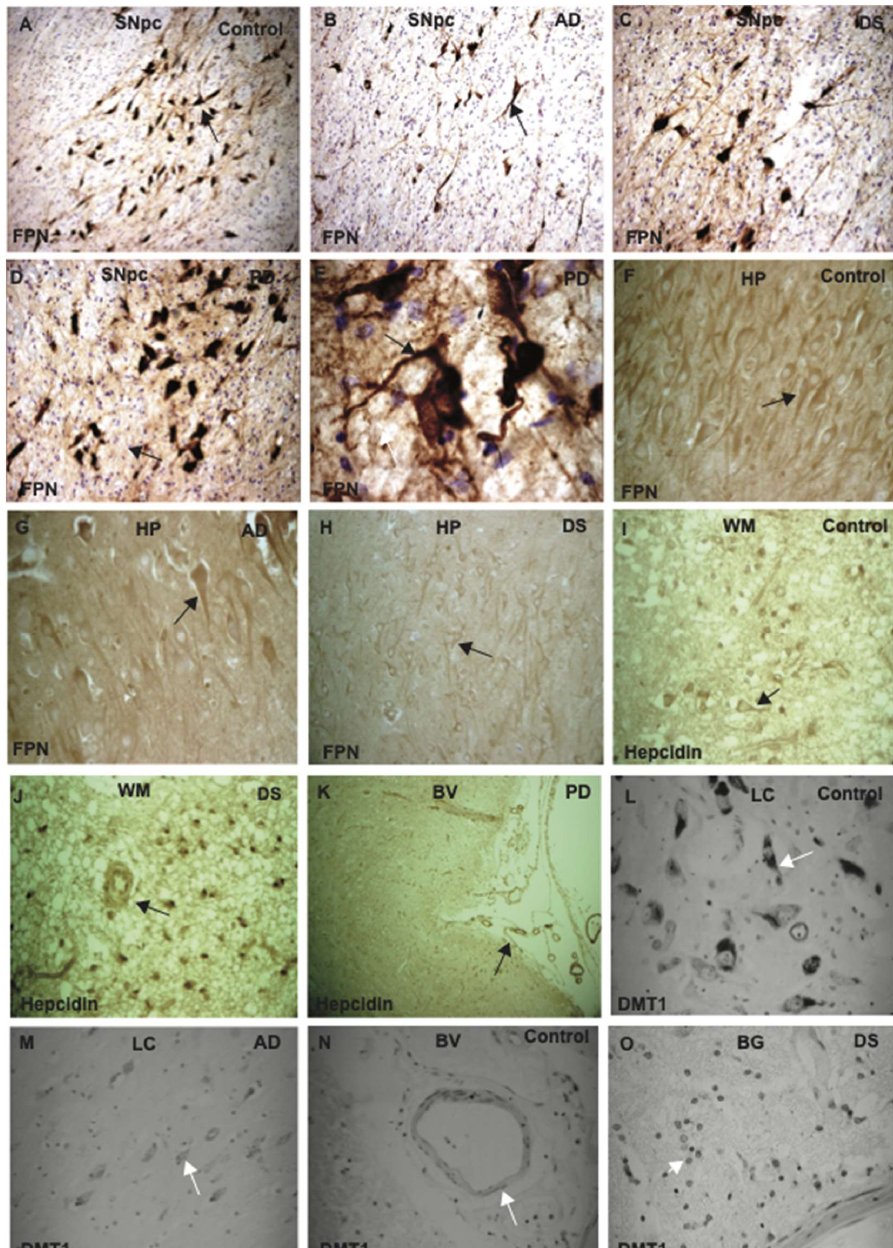
Figure 5. Ferroportin protein expression in the SNpc was higher than in the hippocampus. Ferroportin expression was analysed by IHC using DAB staining. The brain sections from SNpc and BG of PD, AD, DS, and age-matched controls were stained with ferroportin antibody. In controls, AD, and DS brains, the NM cells and long axons and dendrites within SNpc, were stained with ferroportin antibodies ( A – C ). In the PD brains, most of the neurons were damaged and ferroportin accumulation was visible in the cell bodies and axon initial segments (AIS) ( D , E ). In control brain, FPN expresses in the pyramidal neurons of hippocampus (HP), with strong expression in the cell bodies and in the processes ( F ), but less protein expression seen in the HP of AD and DS brains ( G , H ). Hepcidin was visible in the white matter in the oligodendrocytes close to the blood vessels, with stronger expression visible in young DS brains compared to controls ( I , J ). In PD brain sections in BG, hepcidin was visible close to the blood vessels ( K ). DMT1 staining was visible in the NM cells of LC with further reduction in AD brain sections ( L , M ). DMT1 expressed in the wall of blood vessels and in the endosomes ( N , O ). Scale bar: ( A , B , F – K ) = 50 µ m, ( C , D , L – O ) = 25 µ m, ( E ) = 10 µ